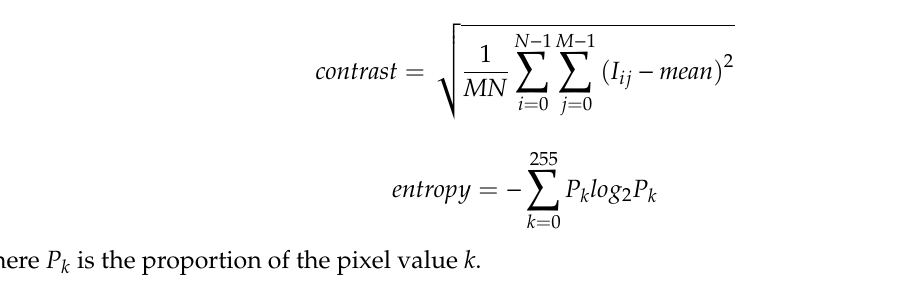
Table 4. Comparison of image quality between the input and composite images. Mean Contrast Entropy Input Composite Input Composite Input